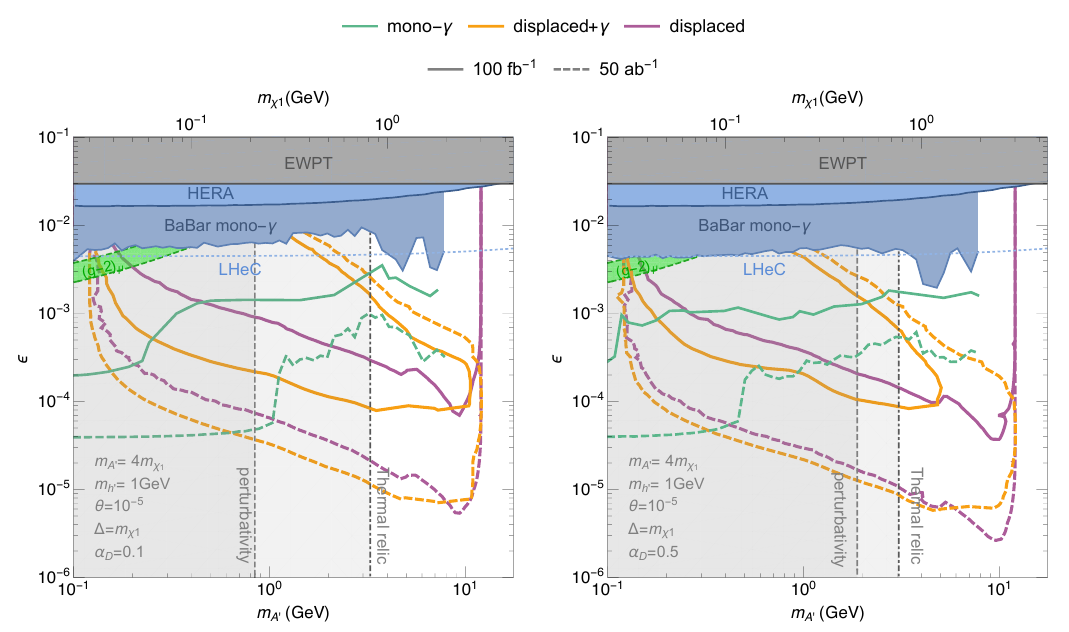
Figure 3 . Expected sensitivities of the different searches at Belle II in the (cid:15) − m A 0 parameter plane for integrated luminosities of 100 fb − 1 (solid lines) and 50 ab − 1 (dashed lines). Left plot is for α D = 0 . 1 , right plot for α D = 0 . 5